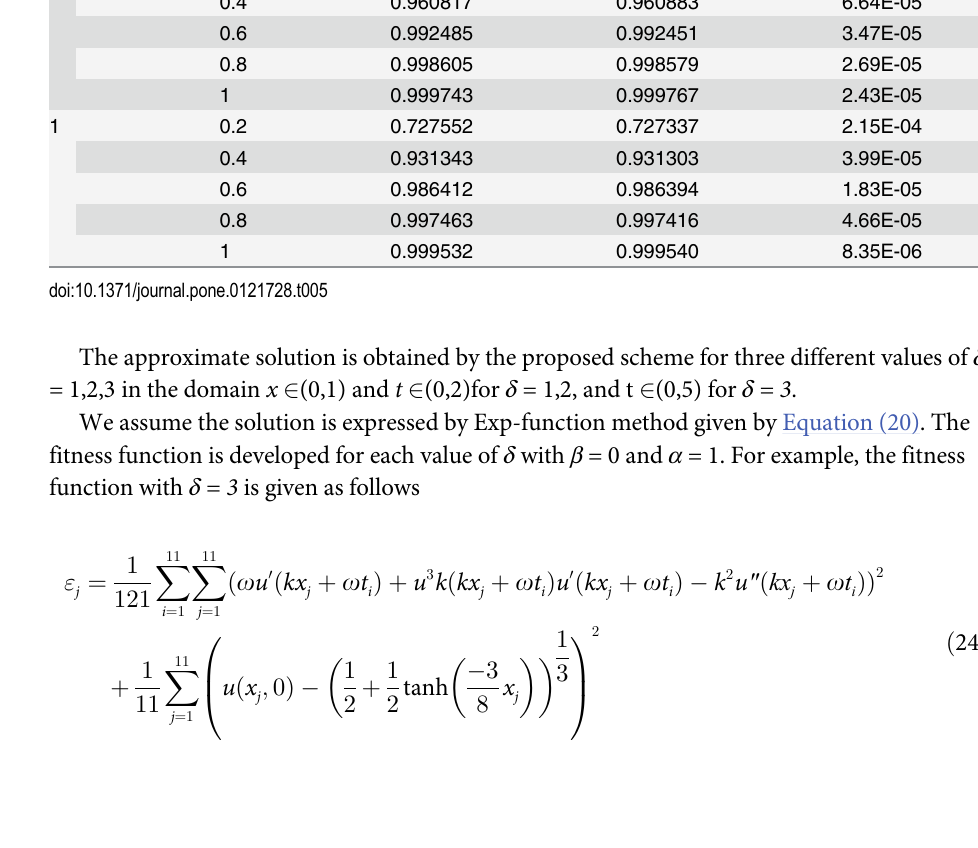
Table 6. Comparison of numerical solutions and absolute errors between the proposed scheme, OHAM[10] and ADM [11] for α = β = 0.001 and δ = 1. Exact Proposed Absolute